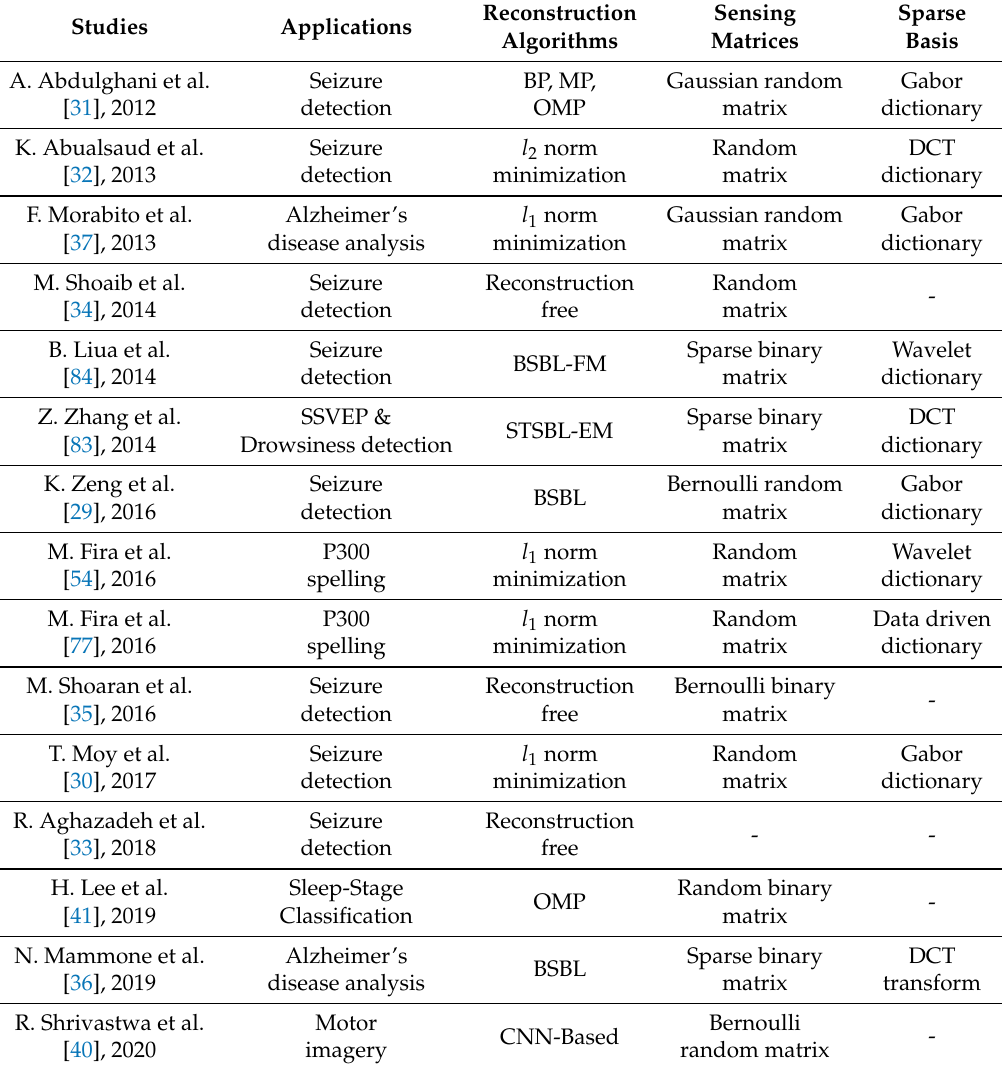
Table 1. A summary of CS applied EEG studies (application